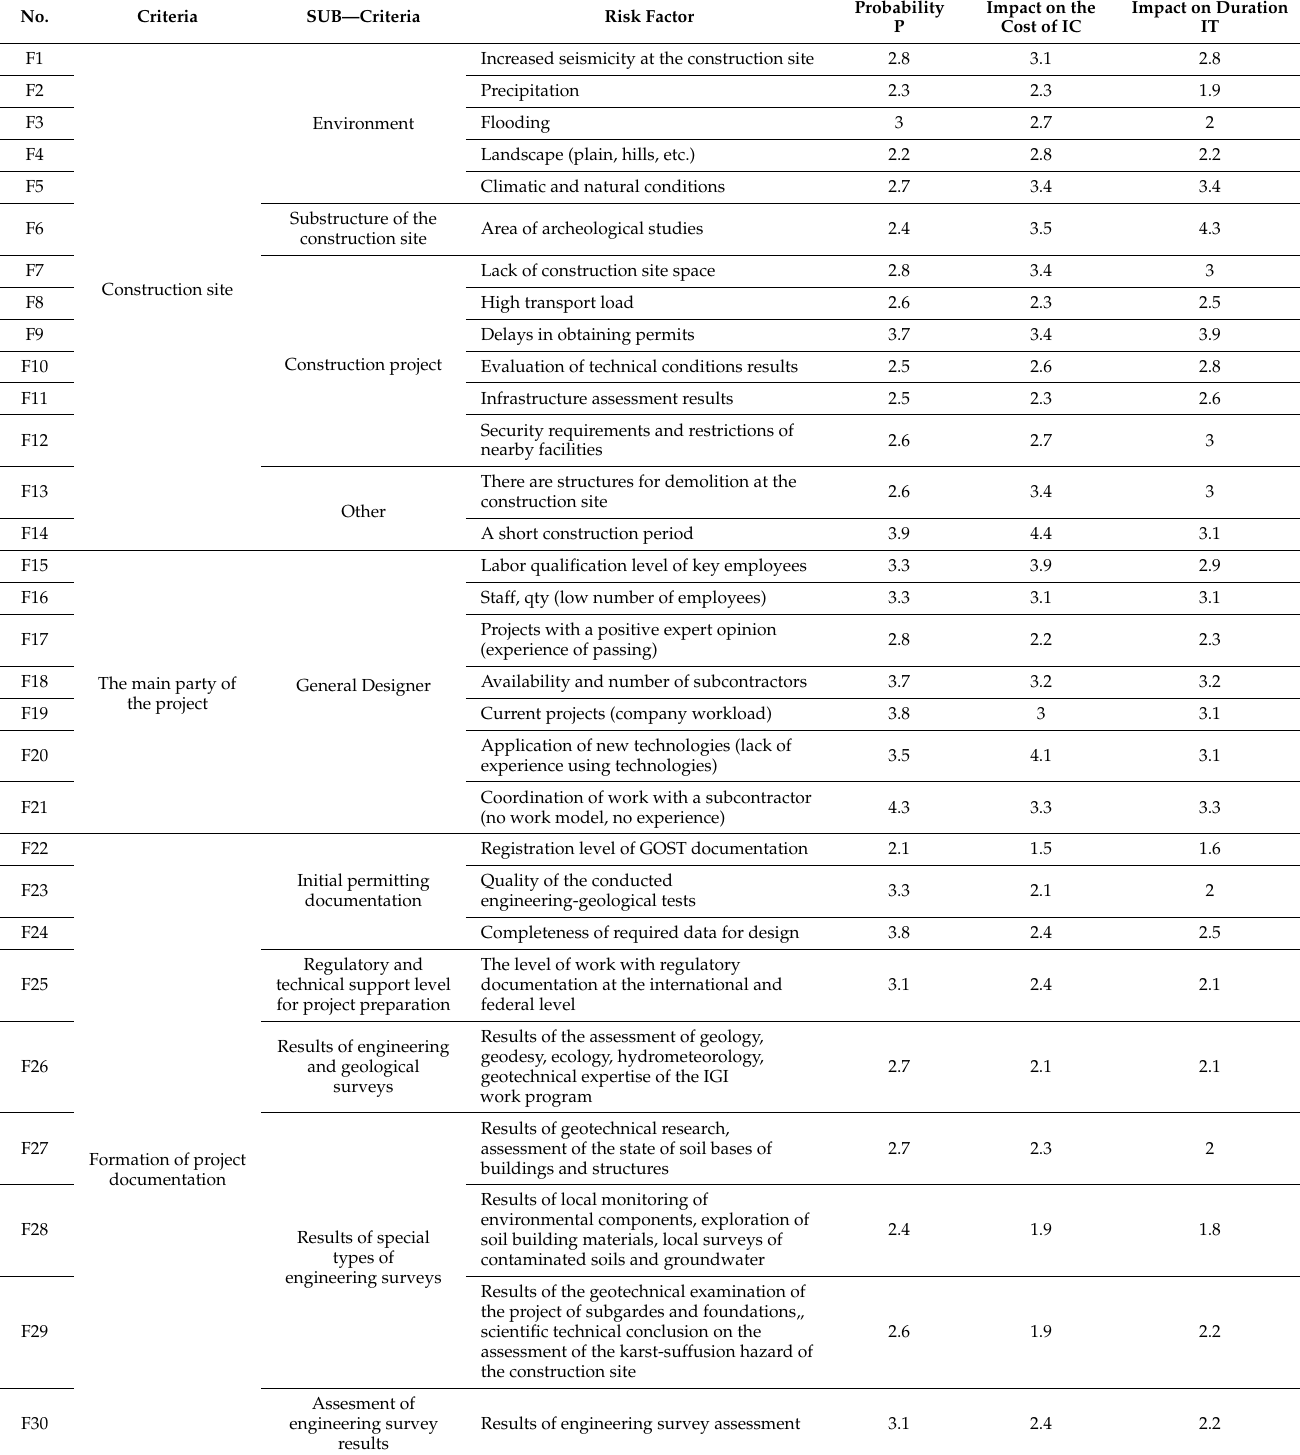
Table 5. Analysis of the expert survey